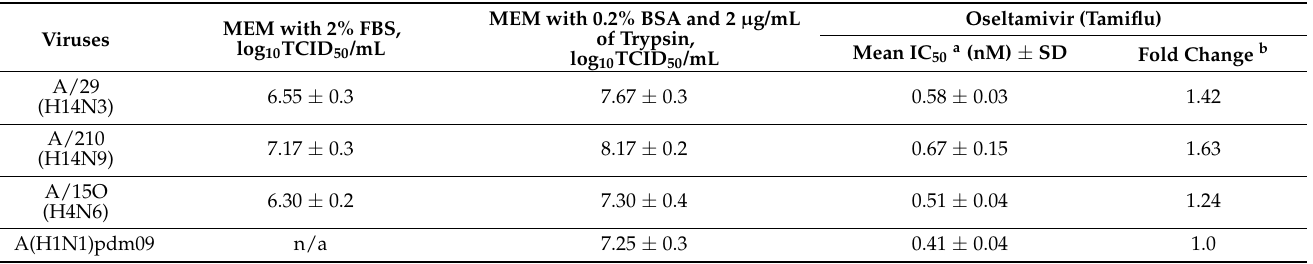
Table 2. Virus titers in MDCK cells and neuraminidase enzyme inhibition assay.